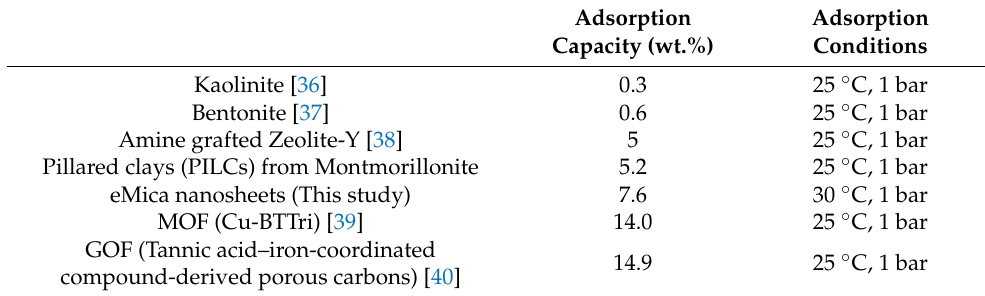
Table 2. Comparison of CO 2 adsorption